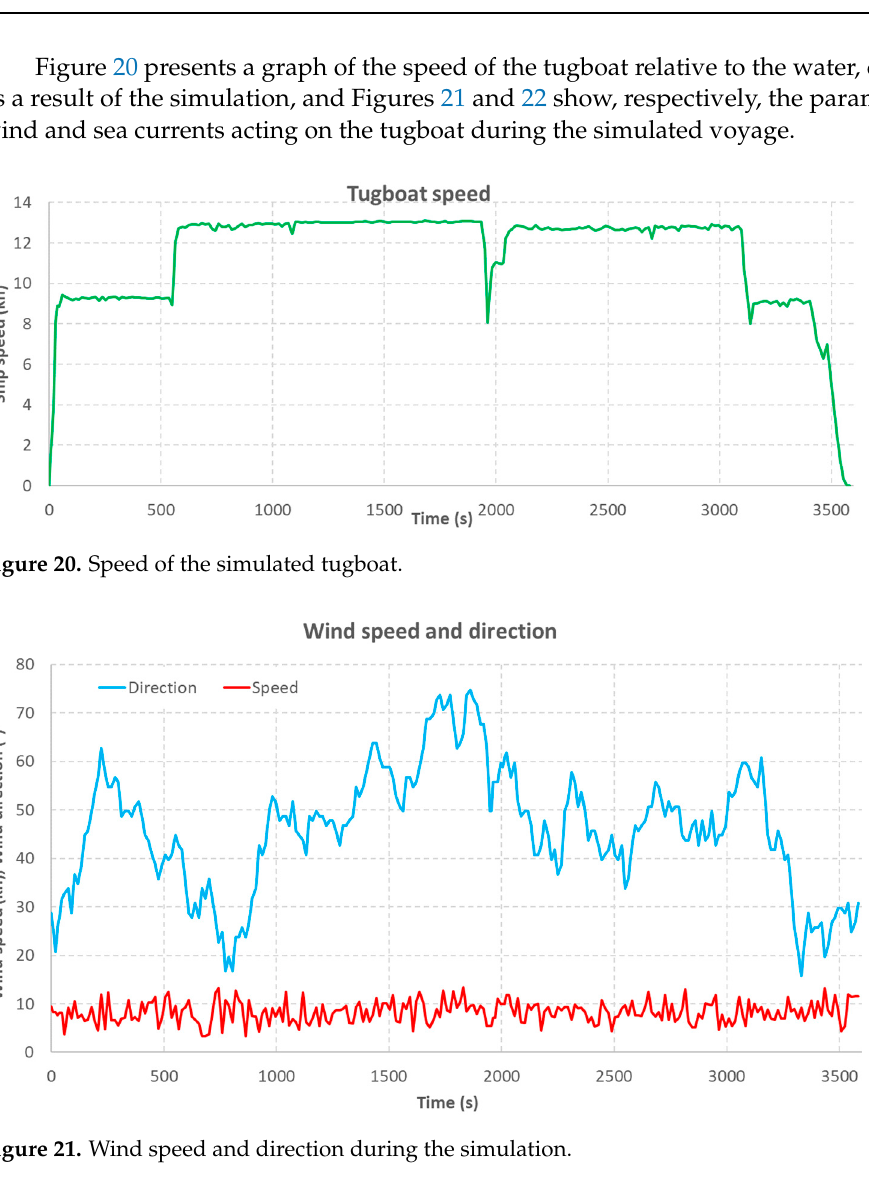
Figure 22. Sea current speed and direction during the simulation. As a result of the implementation of Equation (9) to the speed parameters of the tugboat obtained as a result of the simulation, data on the resistance to which the for- mation of four tugboats would be subjected was obtained. The obtained results are pre- sented in Figure 23: